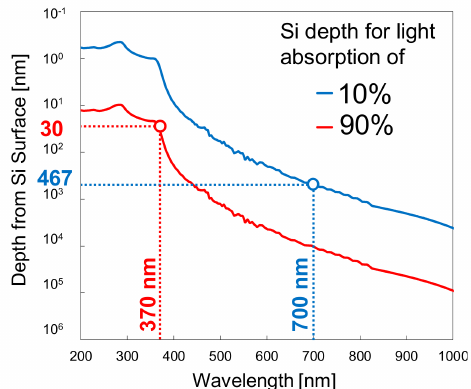
Figure 3. Calculation of the depth from the silicon surface that 10% and 90% of incident light is absorbed, for each